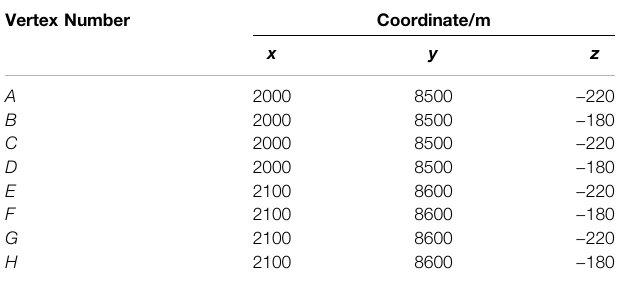
TABLE 2 | Vertex coordinates of the key monitoring